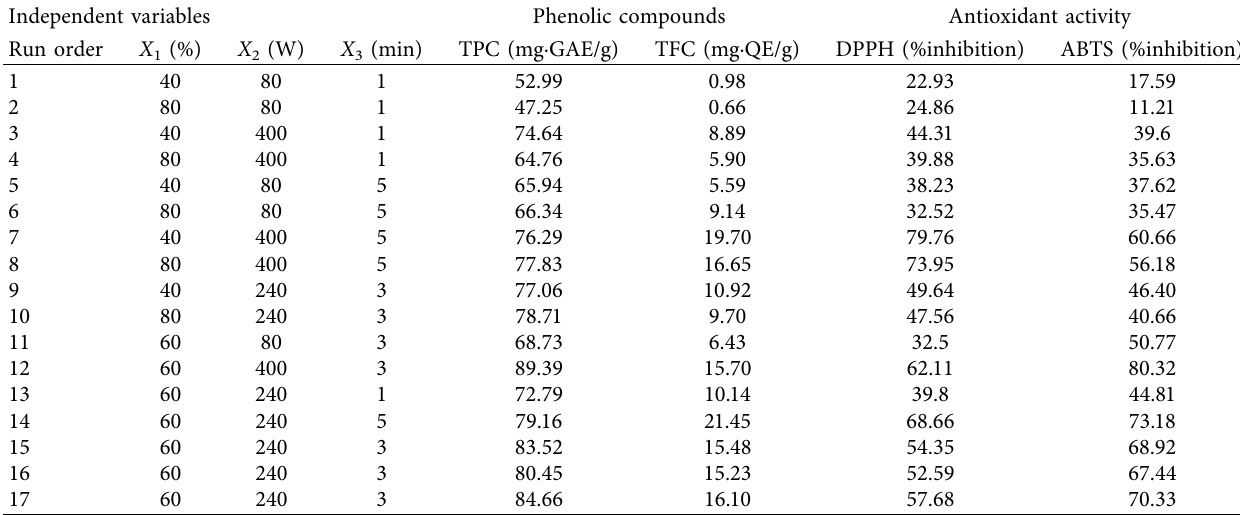
Table 2: Central composite design (CCD) with observed response of the dependent variables from MAE of avocado seeds. Independent variables